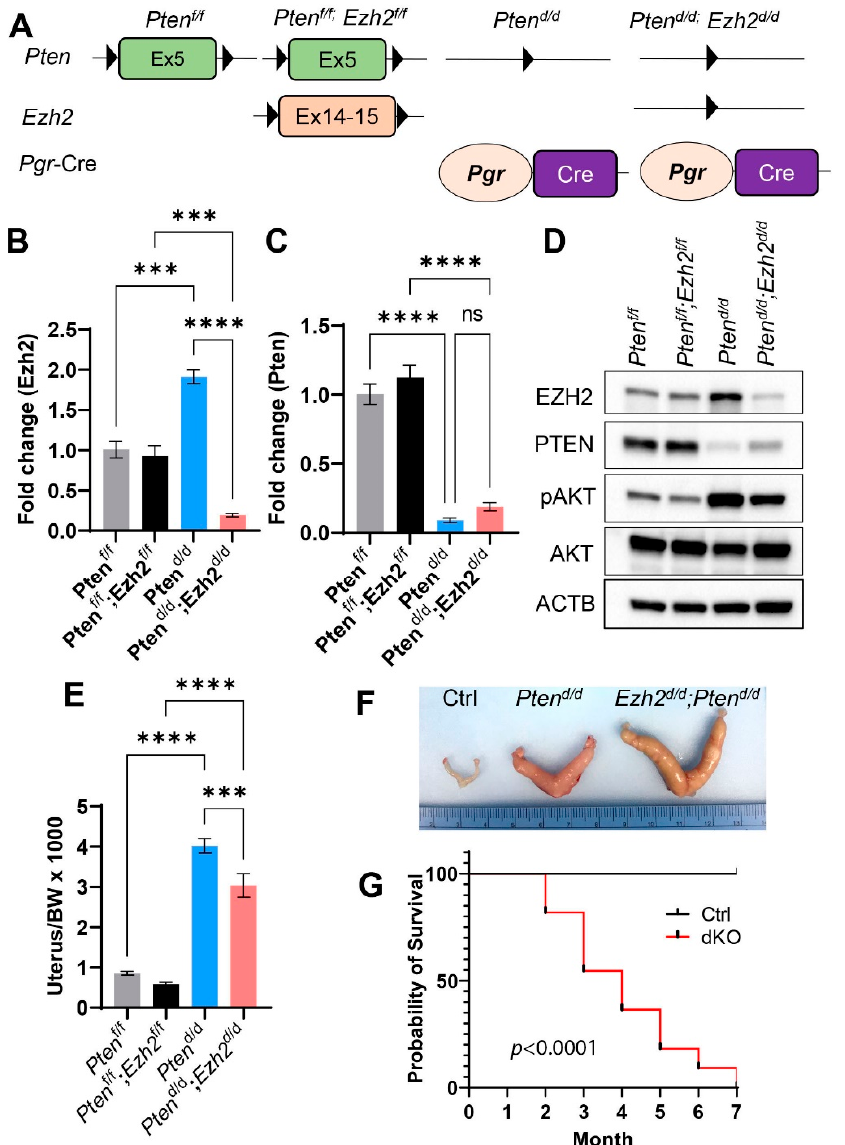
Figure 1. Generation of mice with conditional deletion of Pten and Ezh2 in the uterus. ( A ) A schematic of Cre-LoxP approach to generate conditionally deleted mice. ( B , C ) Transcript levels of Ezh2 and Pten in the mouse uterus at 14 days of age. n = 3–4. Data are mean ± s.e.m. *** p < 0.001 and **** p < 0.0001. ns, not significant. ( D ) Western blot analysis of EZH2, PTEN, pAKT, and AKT in 14-day-old Pten f/f , Pten f/f ; Ezh2 f/f , Pten d/d , and Pten d/d ; Ezh2 d/d uteri. ACTB was used as an internal control. n = 4. ( E ) Ratios of the uterus/body weight (BW) in Pten f/f , Pten f/f ; Ezh2 f/f , Pten d/d , and Pten d/d ; Ezh2 d/d mice at three weeks of age. n = 9–13. Data are mean ± s.e.m. *** p < 0.001 and **** p < 0.0001. ( F ) Gross image of uteri from nine-week-old Pten f/f (Ctrl), Pten d/d , and Pten d/d ; Ezh2 d/d mice. ( G ) Kaplan–Meier survival curves of Pten f/f ; Ezh2 f/f (Ctrl) and Pten d/d ; Ezh2 d/d mice. n =